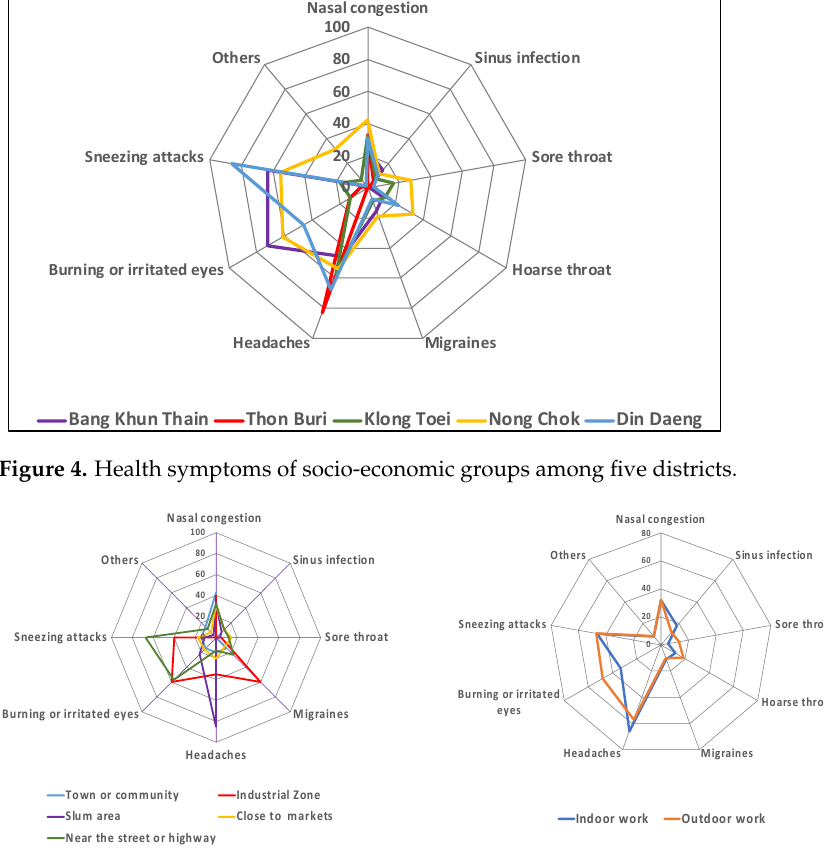
Figure 5. Health symptoms of socio-economic groups among different work environments.